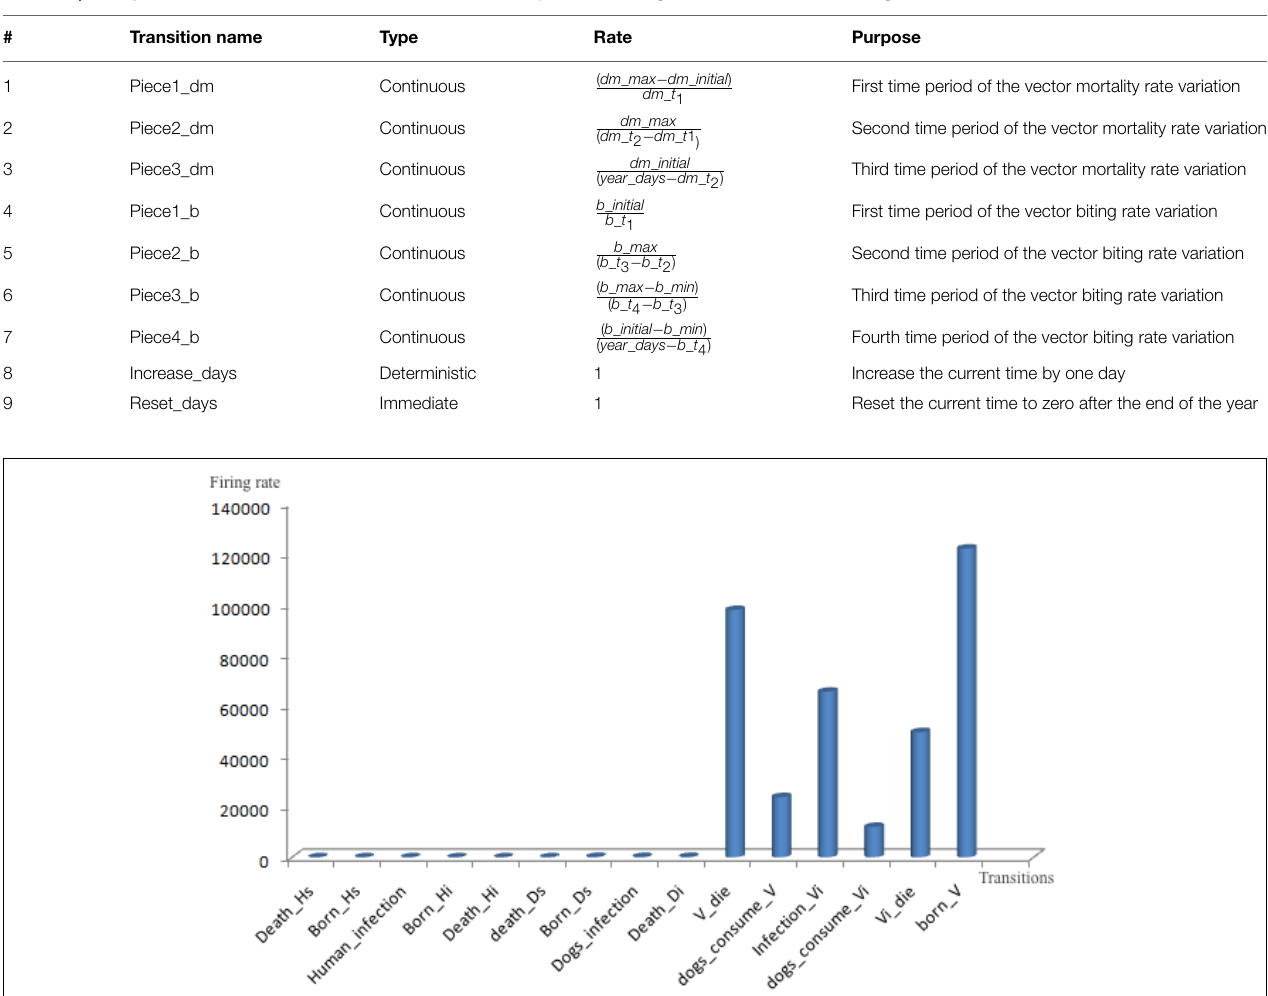
TABLE 2 | The specification of the transitions involved in mortality and the biting rate of the submodel in Figure 6.